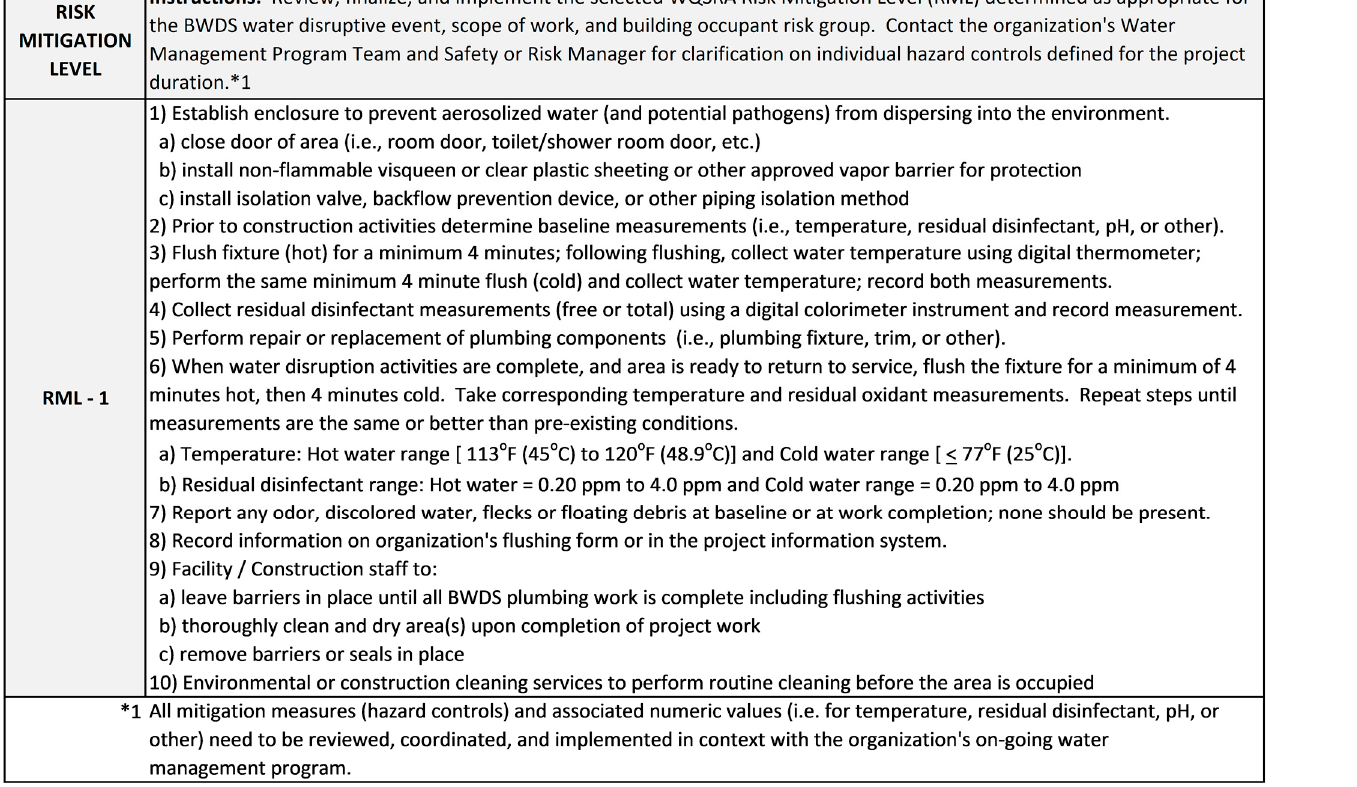
Figure 6. WQSRA risk mitigation level 1 (RML-1). Adapted with permission from Ref. [50]. 2022, Scanlon et al. (CC BY 4.0).